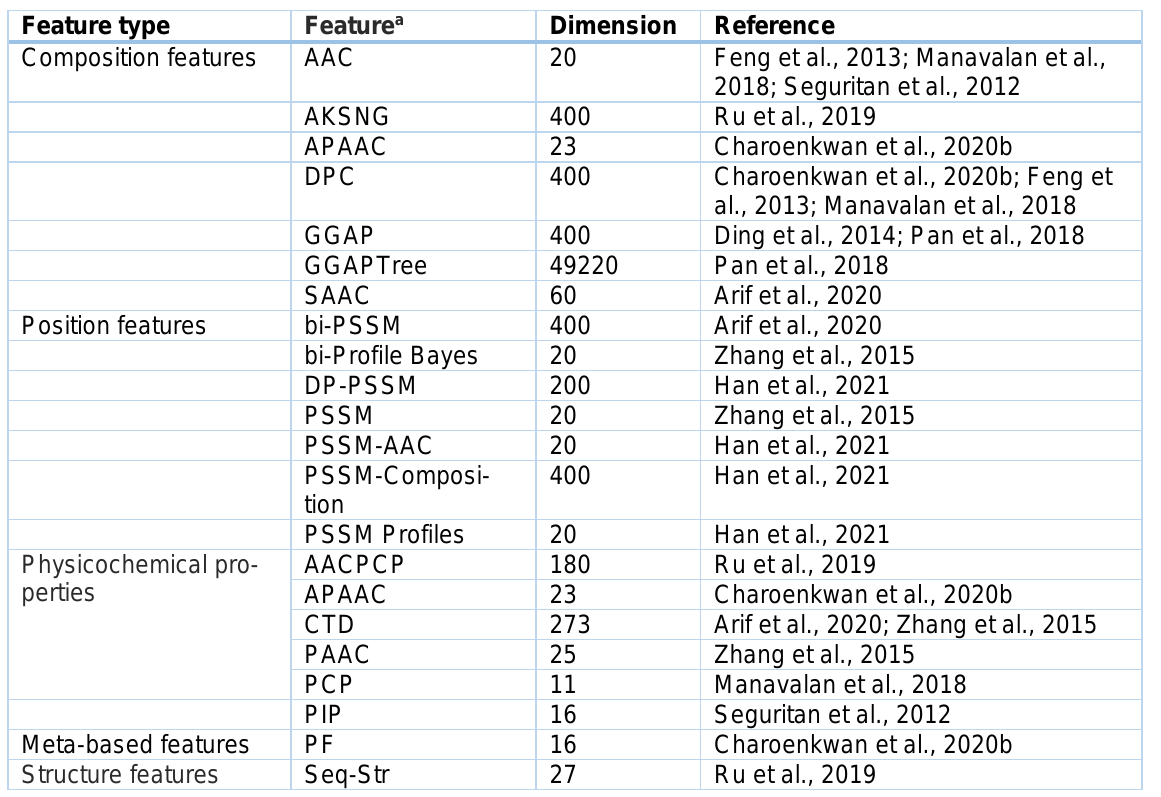
Table 3: Different types of features employed for developing the PVP